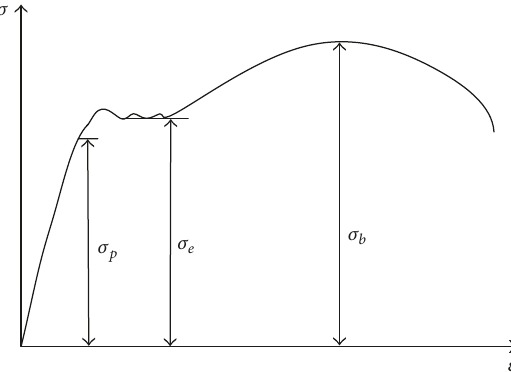
Figure 9: The normal stress-strain curve for grade 45